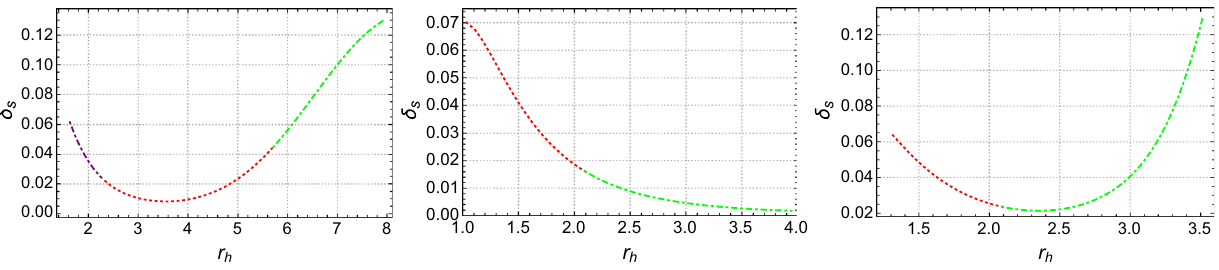
Fig. 8 The variations of the distortions for the Kerr-AdS, Kerr and Kerr-dS black holes with respect to the event horizons of the black holes. The parameters are set to be J = 1 , (cid:13) = − 0 . 03 , θ O = π/ 4